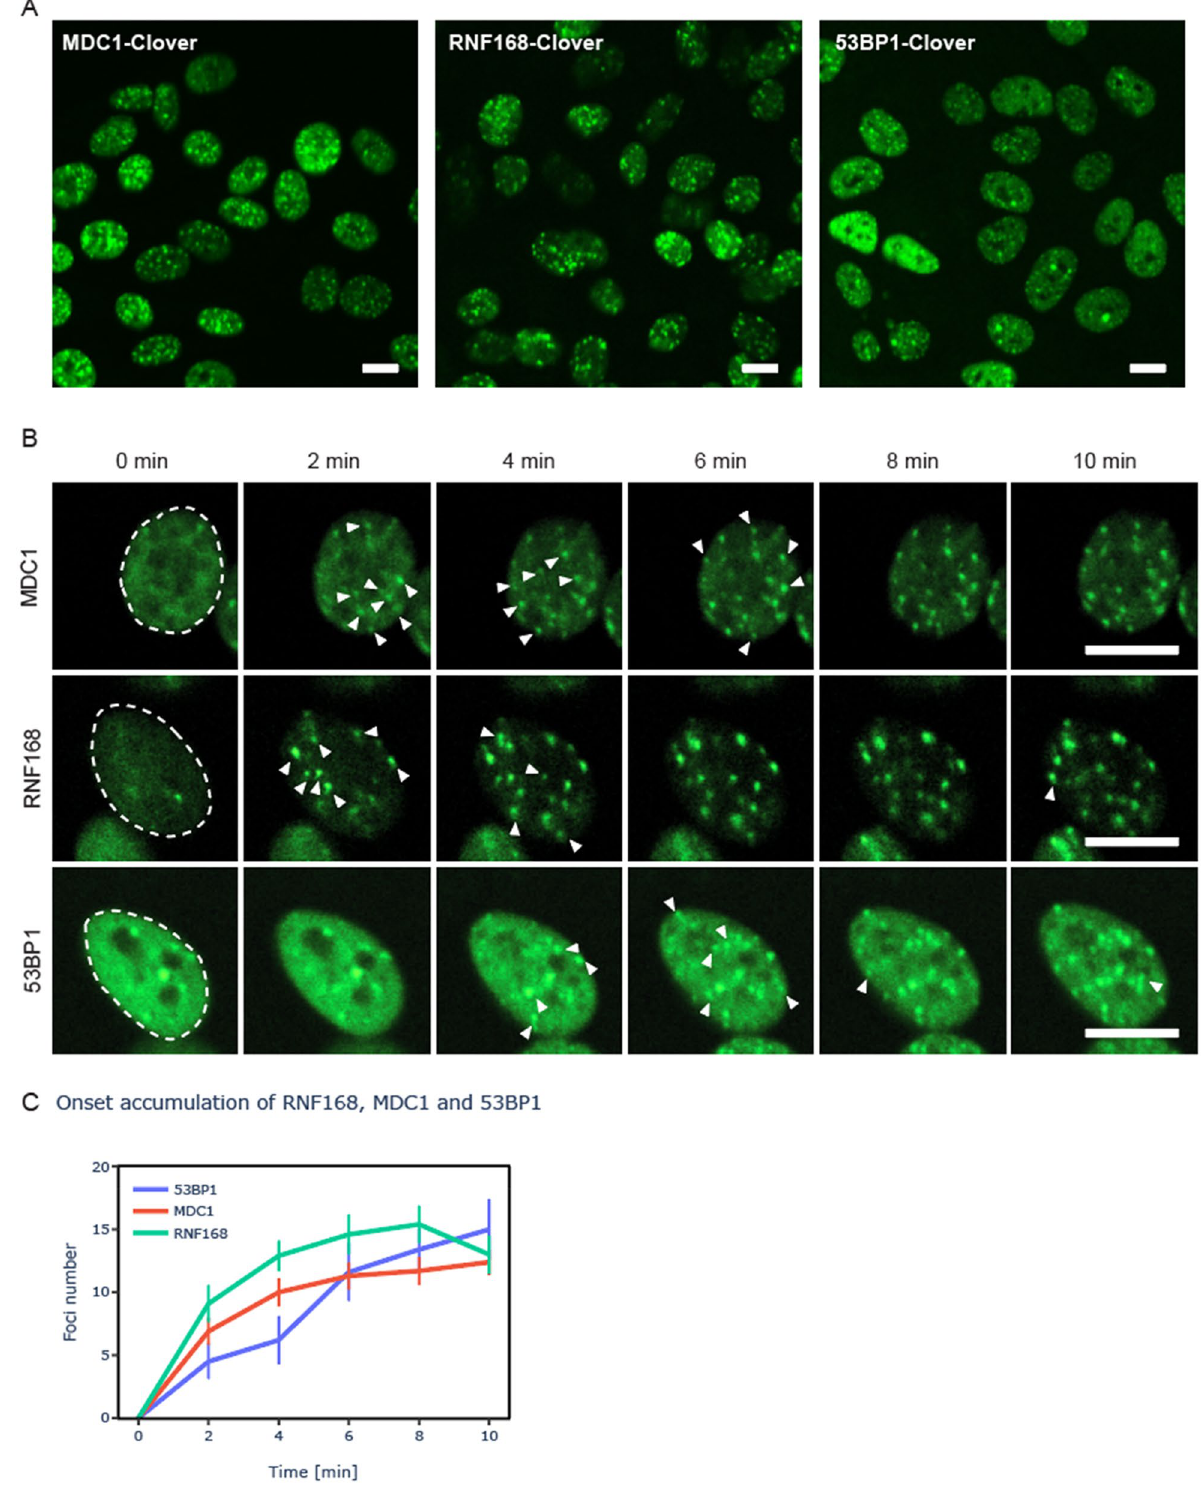
Figure 3. Asynchronous accumulation of MDC1, RNF168 and 53BP1 at α-particle induced DSBs. ARPE19 cells expressing the indicated fluorescently-tagged proteins have been irradiated with ~ 1 Gy of 360 MeV α-particles and imaged for 16 min at 2-min intervals. ( A ) Overview of a single imaged field 10 min after irradiation. All images were 3D scans, processed by deconvolution and then converted into a single maximum intensity projection. ( B ) Galleries showing projections of individual 3D images acquired at the indicated time- points. The white arrows indicate newly appearing foci. ( C ) A number of foci per cell as a function of time. At least 30 cells have been analyzed per data point. Error bars: standard error of the mean (SEM). Scale bar: 10